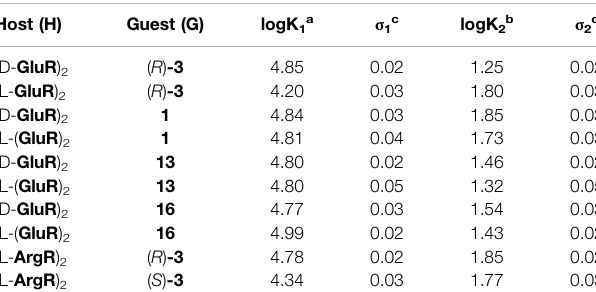
TABLE 1 | Complexation constants determined by 1 H NMR titrations and subsequent curve fi tting using HypNMR (D 2 O, pH = 4.8, 298